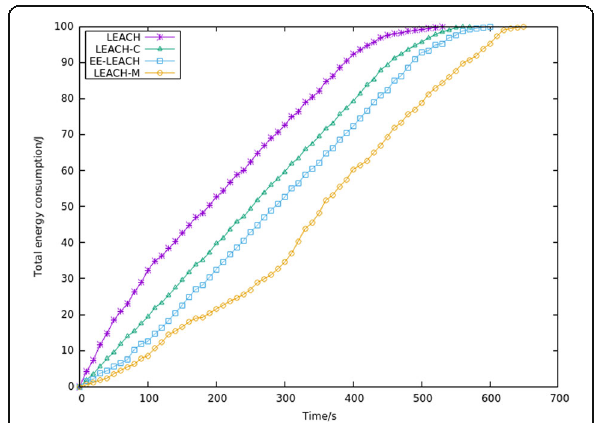
Fig. 6 The comparison of received data at BS for LEACH, LEACH-C, EE-LEACH, and LEACH-M in 100 × 100m 2